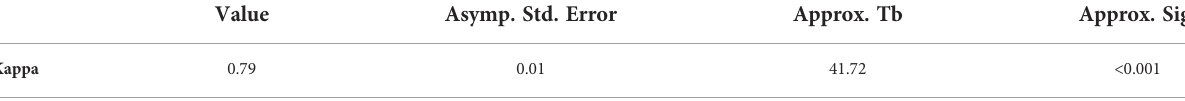
TABLE 4 Consistency evaluation of two methods for H. pylori resistance (n = 2723).